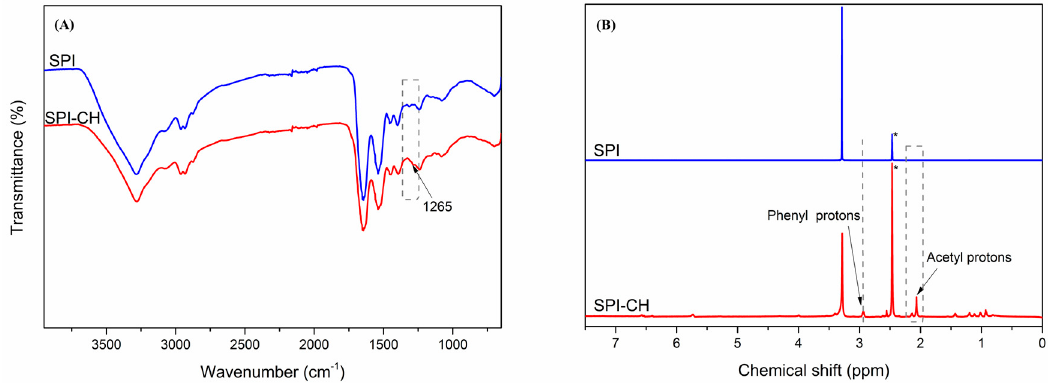
Figure 1. ( A ) FT-IR spectra SPI and SPI-CH powder; ( B ) 1H NMR spectrum of SPI and SPI-CH in DMSO.